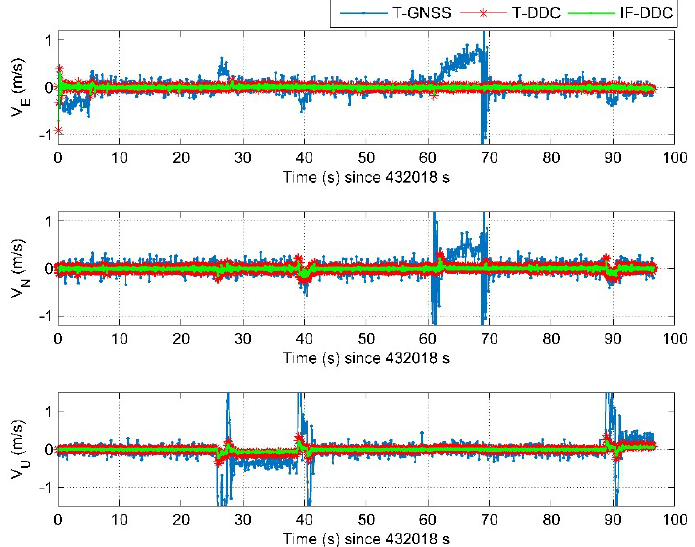
Figure 14. The velocity errors of the dynamic test using different methods in polar areas.